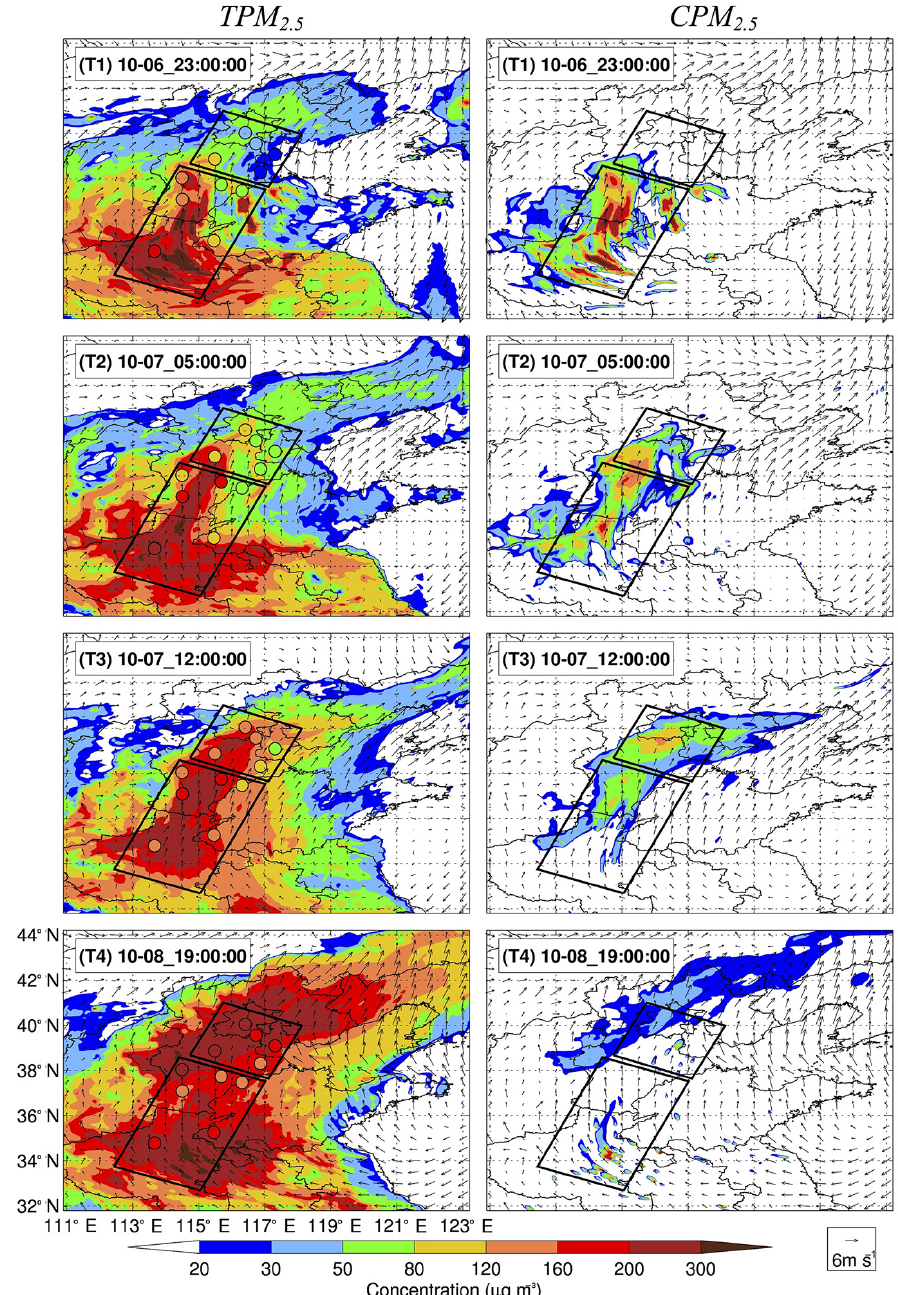
Figure 9. The distributions of TPM 2 . 5 and CPM 2 . 5 of the key point-in-local-times of T1, T2, T3 and T4, which represent different pollution phases of emission from CFB to PM 2 . 5 . Left panels also show the pattern comparisons of simulated vs. observed near-surface PM 2 . 5 concentrations (TPM 2 . 5 ) , with PM 2 . 5 observations of colored circles. Black arrows denote simulated surface